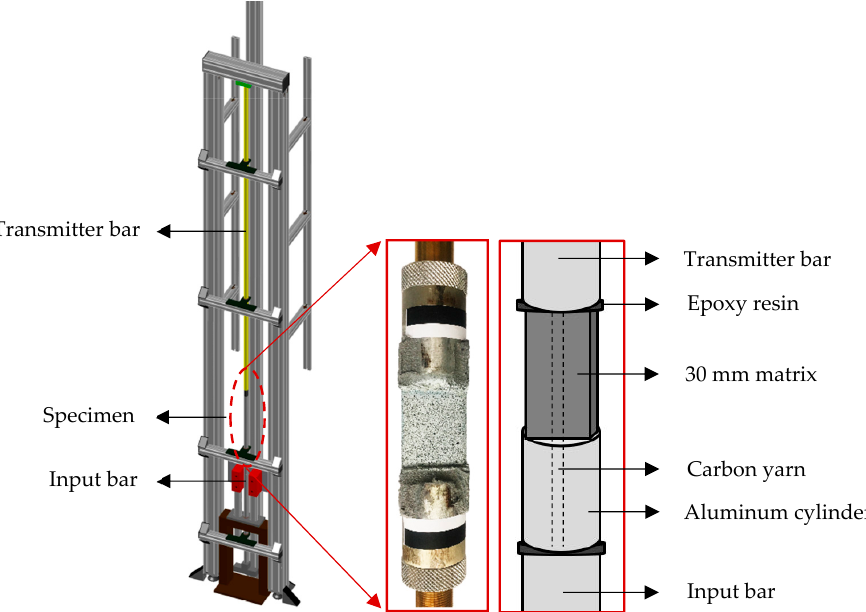
Figure 6. Testing configuration of the gravitational split Hopkinson tension bar (SHTB) for impact tension and single-yarn pullout test.